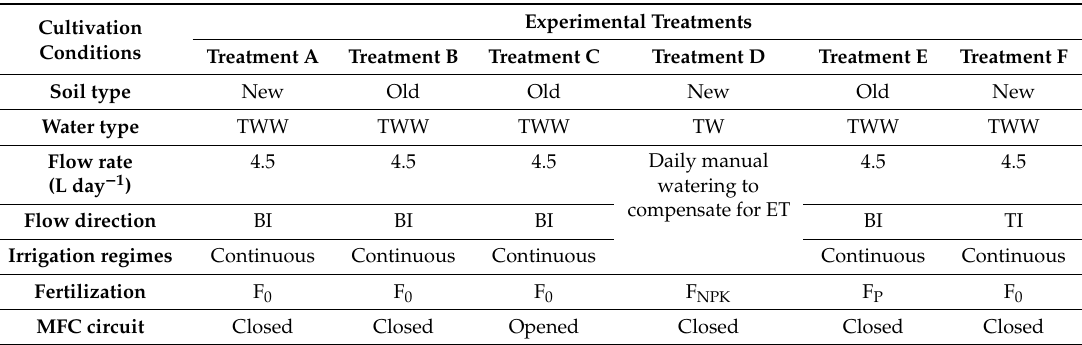
Table 1. Cultivation conditions of experimental